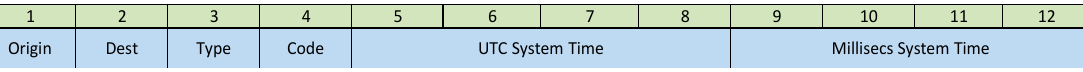
Figure 3. Structure of the Hello message.